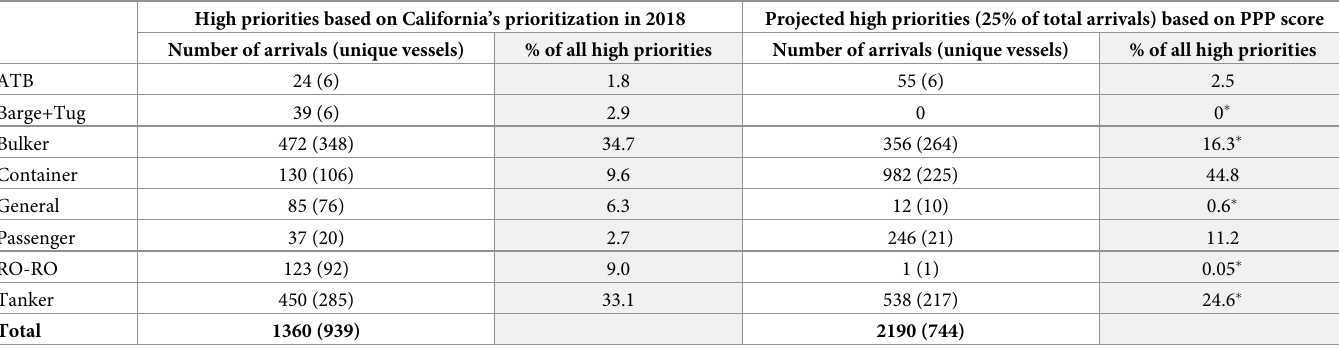
Table 3. Comparison of prioritization